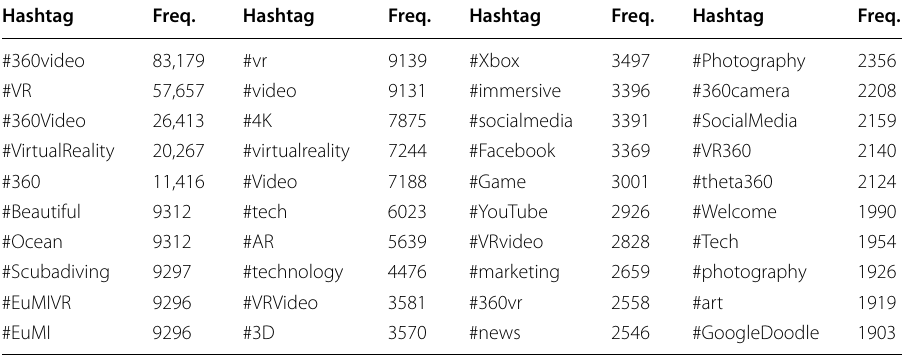
Table 3 Frequency of the top-40 most commonly used hashtags within the tweets in the years of Hashtag